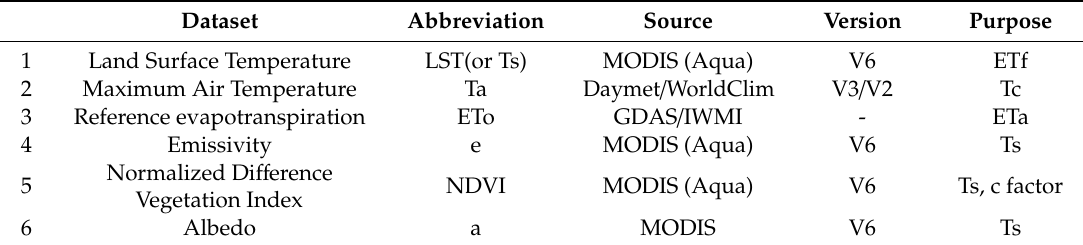
Table 1. Summary of input datasets used in the Operational Simplified Surface Energy Balance